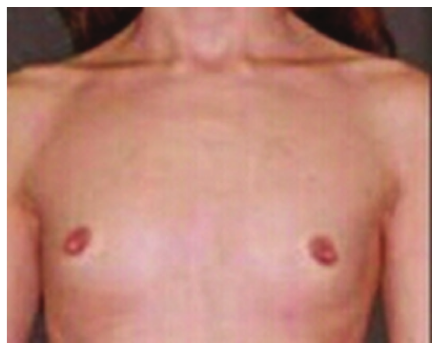
Figure 2: Lack of breast development.